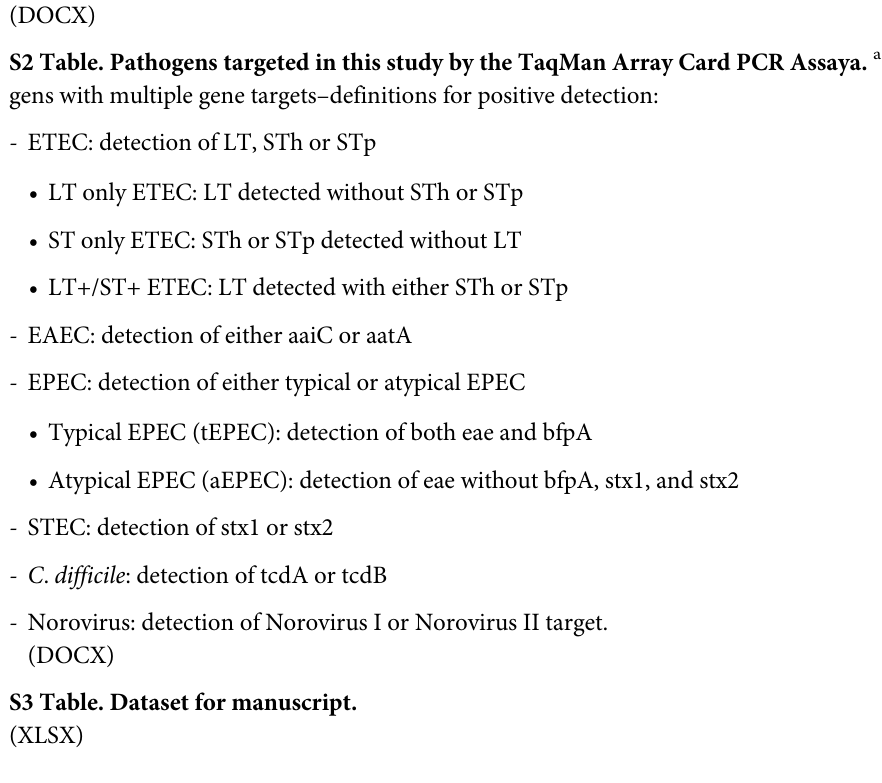
S1 Table. Comparison of enterotoxin and CF detection on 59 ETEC positive stool samples